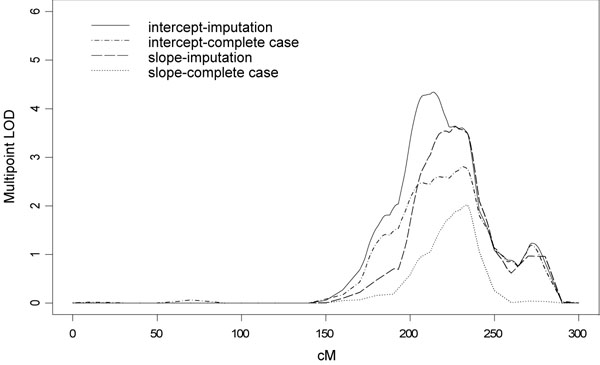
Multipoint linkage analysis: chromosome 1